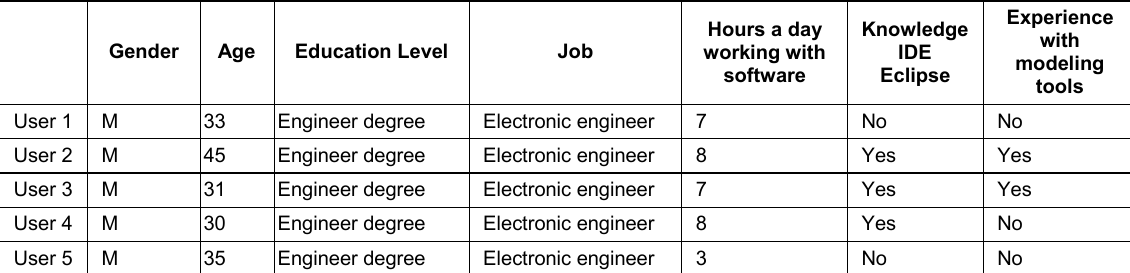
Table 3. Characteristics of